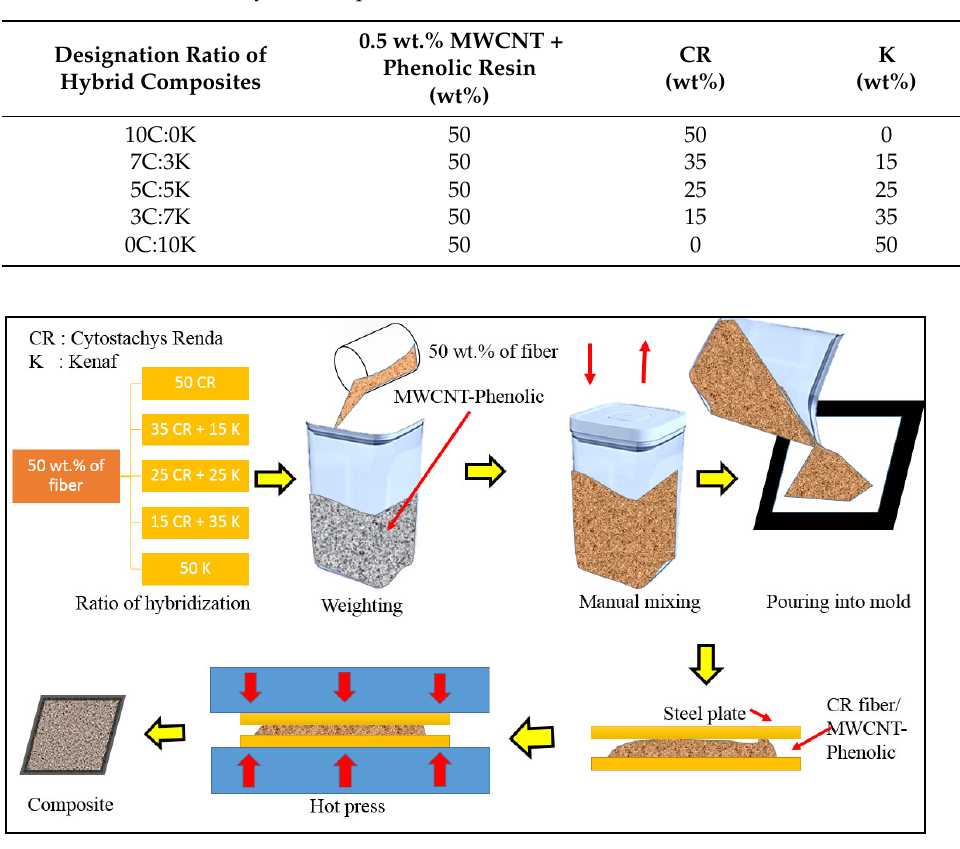
Table 2. Formulation of hybrid composites.